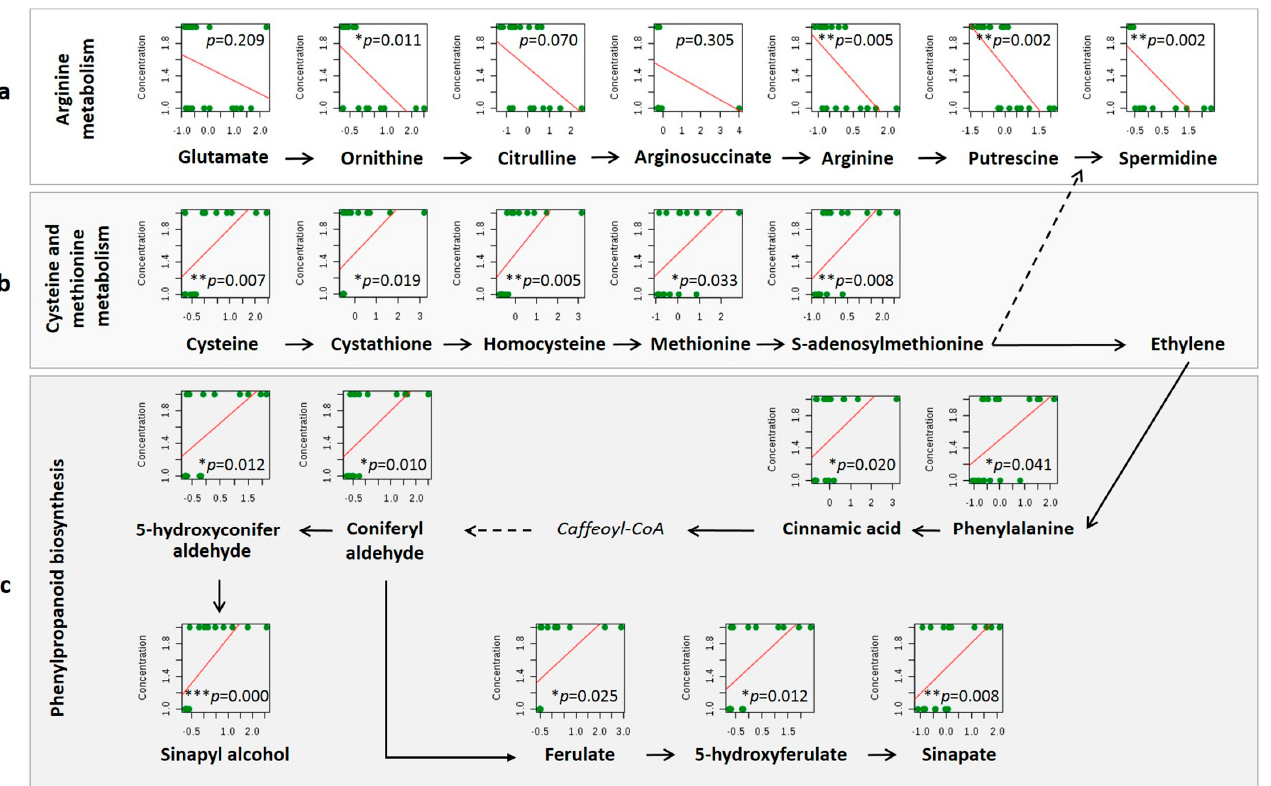
Figure 9. Metabolomics Pathway Analysis (MetPA) of grain tissue from the resistant Fhb7E (HOM+) vs. susceptible (HOM − ) lines at maturity, after inoculation with Fg . All the matched pathways are displayed as circles. The colour of each circle is based on p -values (darker colours indicate more signi fi cant changes of metabolites in the corresponding pathway), whereas the size of the circle corresponds to the pathway impact score. The most impacted pathways, having high statistical signi fi cance scores, are annotated by their full name.